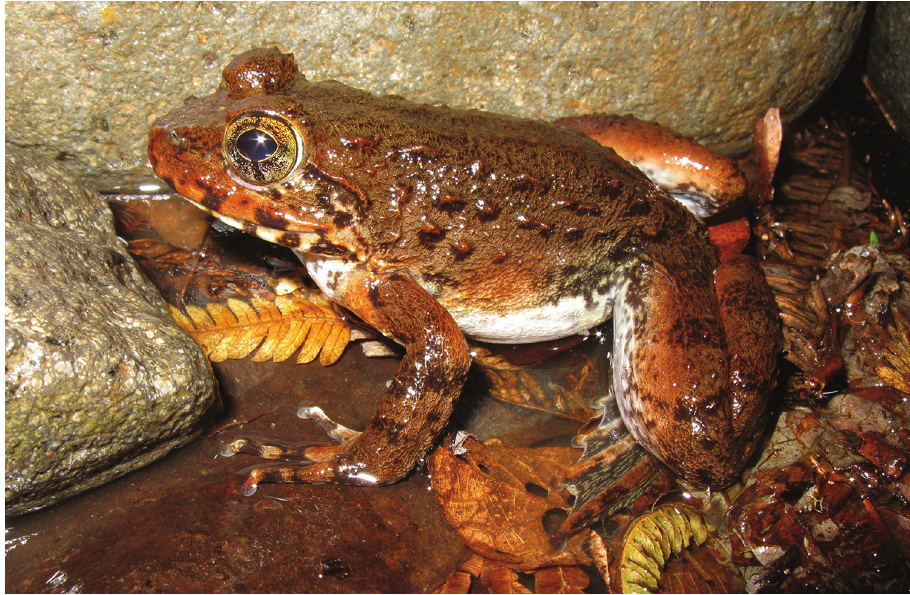
Figure 13. Limnonectes diautus male (KU 320112) from 1900 masl, Mt. Balatukan, Municipality of Gingoog, Misamis Oriental Province. Photo: